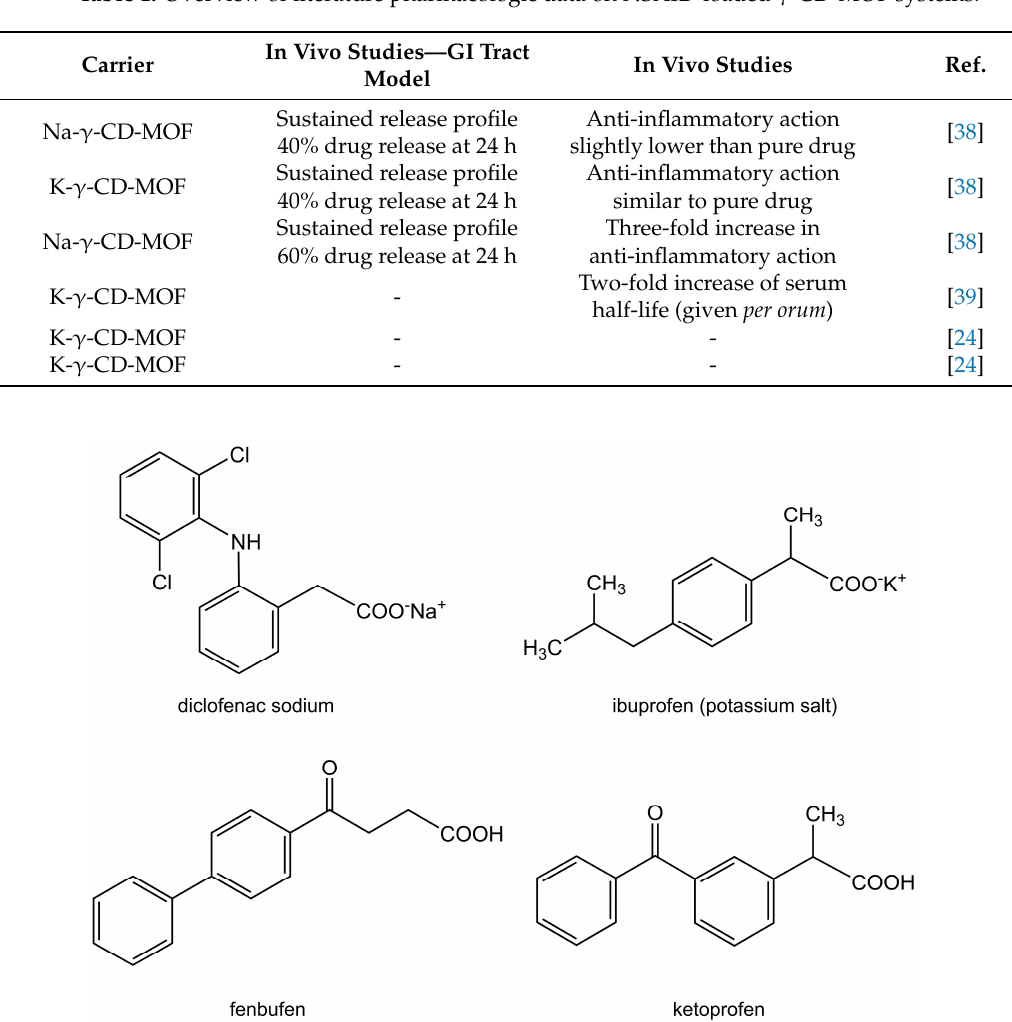
Figure 5. Overview of the preparation steps for the K + -γ-CD-MOF and its derived cubic-shaped gel: ( i ) the MOF is prepared from K + and γ-CD by crystallisation; ( ii ) γ-CD-MOF crystals are treated with the cross-linking agent (L); ( iii ) K + ions are removed to obtain the gel particles, which retain the cubic shape as demonstrated by its SEM image (right). Reprinted with permission from Furukawa et al . [41].